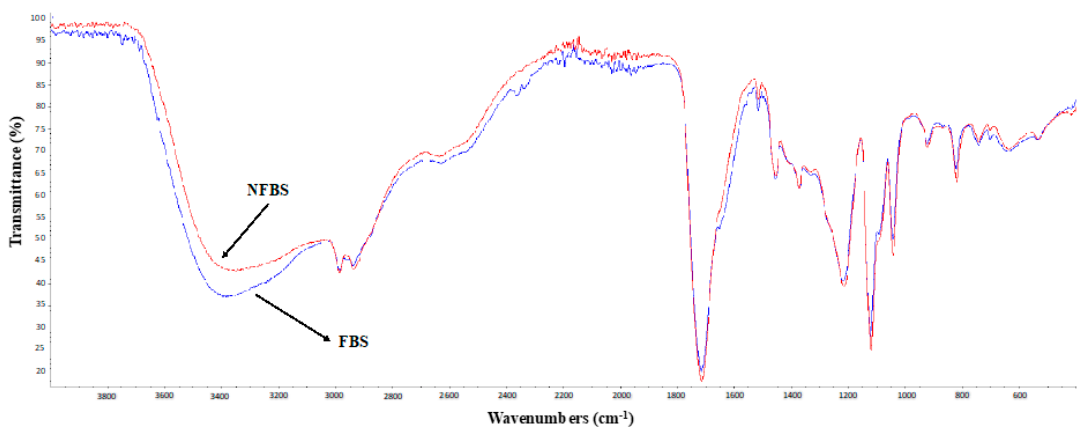
Figure 2. Comparison of the Fourier-Transform Infrared Spectroscopy (FTIR) spectra of the biosurfactant extracted with ethyl acetate from corn steep water (CSW) before (NFBS, red line) and after (FBS, blue line) a filtration stage.